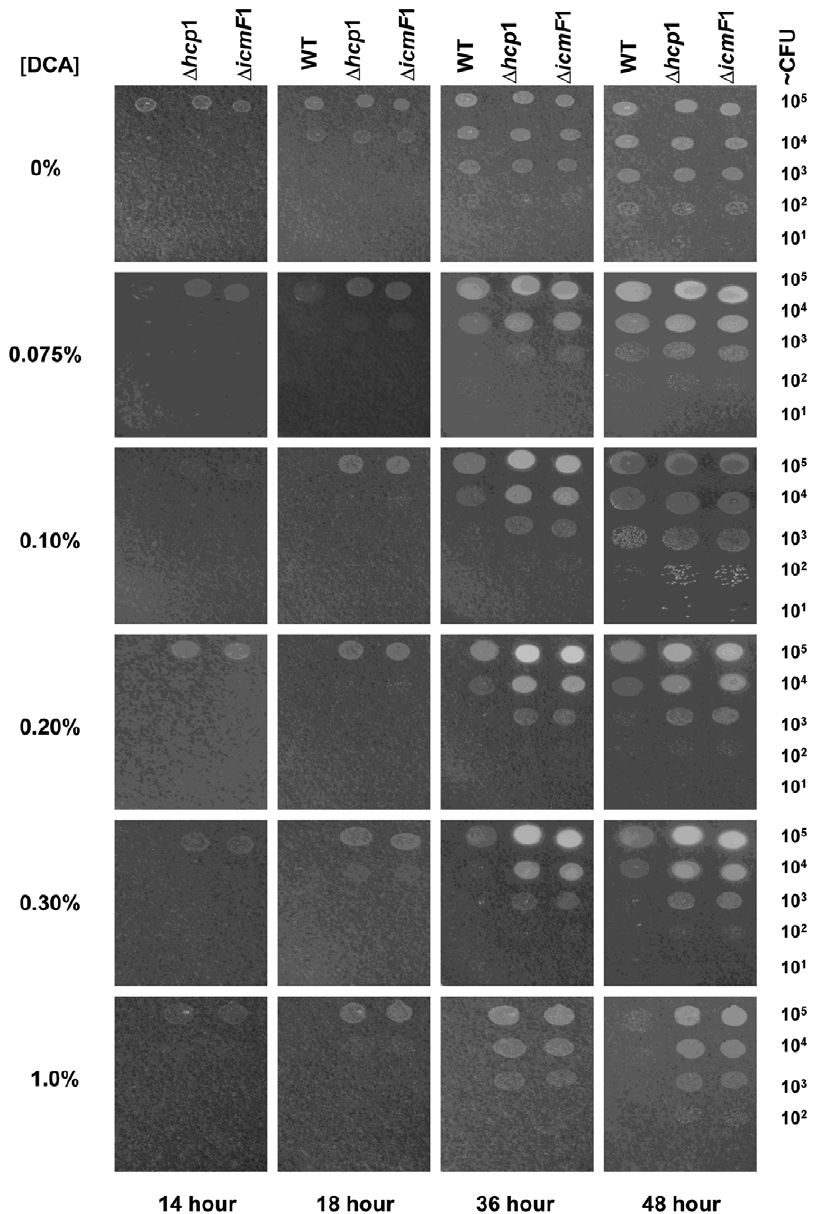
Figure 3. Growth dynamics of WT C.jejuni , the D hcp1 mutant, and the D icmF1 mutant in various sub-inhibitory concentrations of DCA. Ten-fold serial dilutions of WT and the mutants were spotted on agar plates lacking or supplemented with DCA at concentrations ranging from 0% to 1%. Growth was inspected at 14, 18, 36 and 48 hours after incubation under microaerobic conditions. The results are representative of three independent experiments.